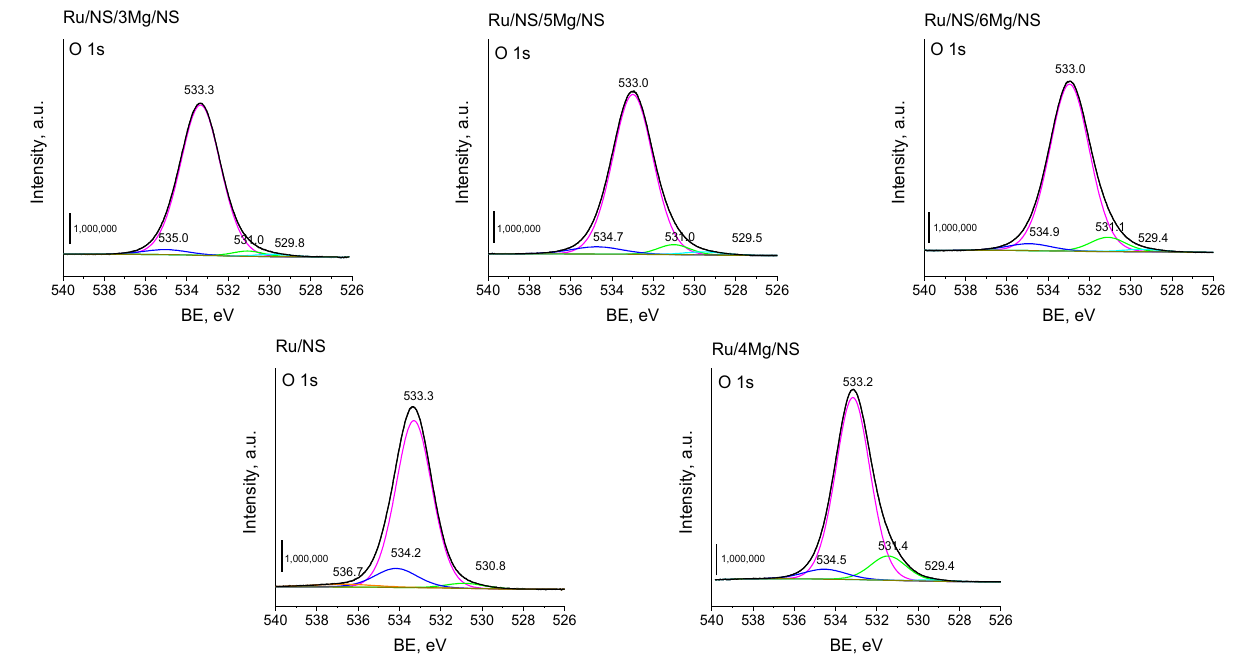
Figure 4. XPS spectra of the catalysts in the O 1s region.